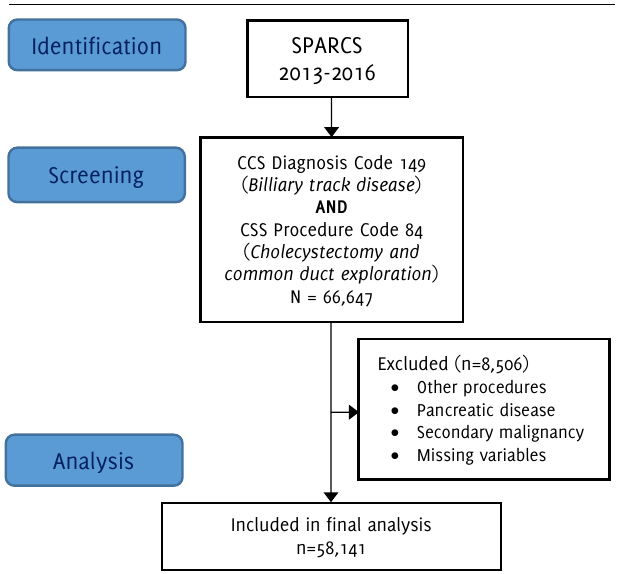
Figure 1 . Patient Flow Chart